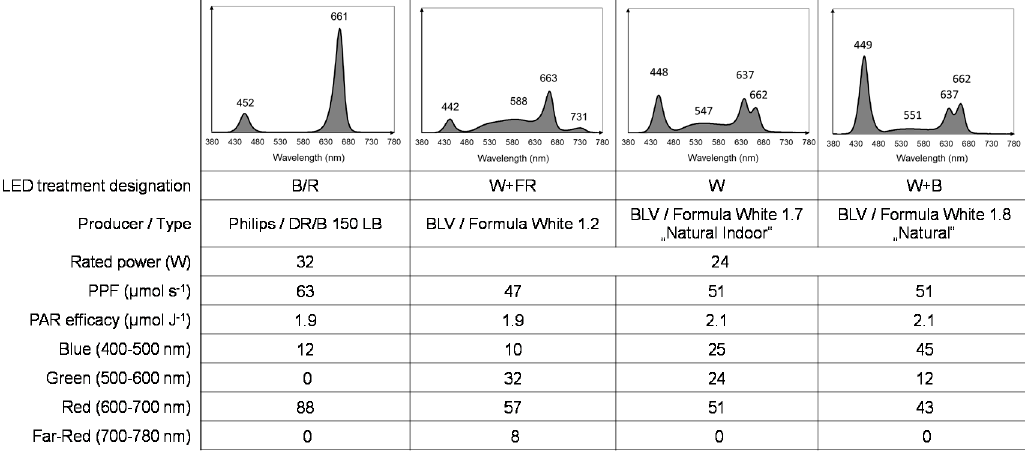
Figure 2. Light spectra used. The technical specifications of the LEDs were taken according to the manufacturer. Below each LED treatment, the percentage distribution is given for defined wavelength ranges as measured according to own measurements with a hand ‐ held spectrometer.